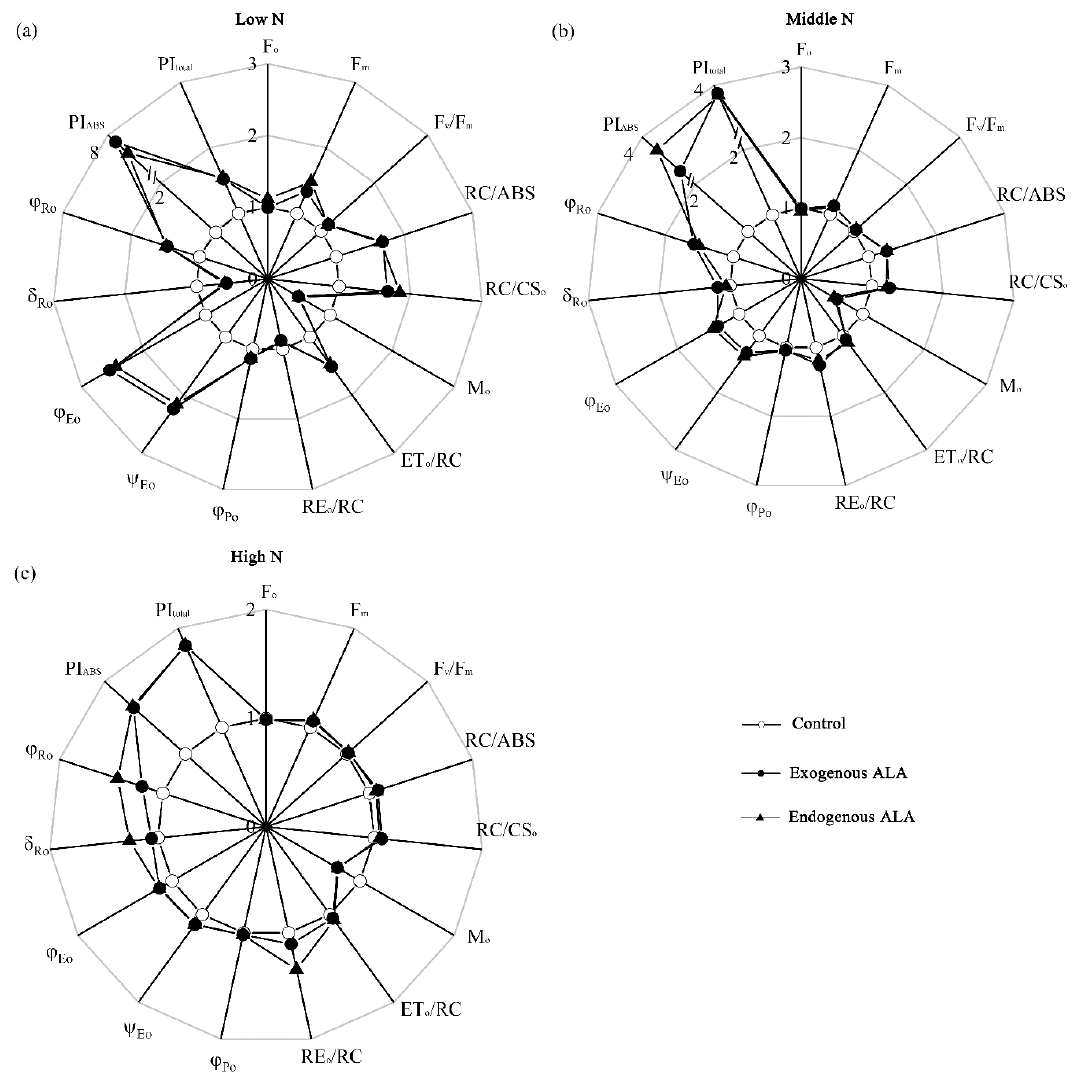
Figure 4. Radar plots of changes in JIP test parameters in exogenously treated and endogenous ALA- overproducing canola leaves relative to controls under ( a ) low-, ( b ) middle-, and ( c ) high-N conditions.